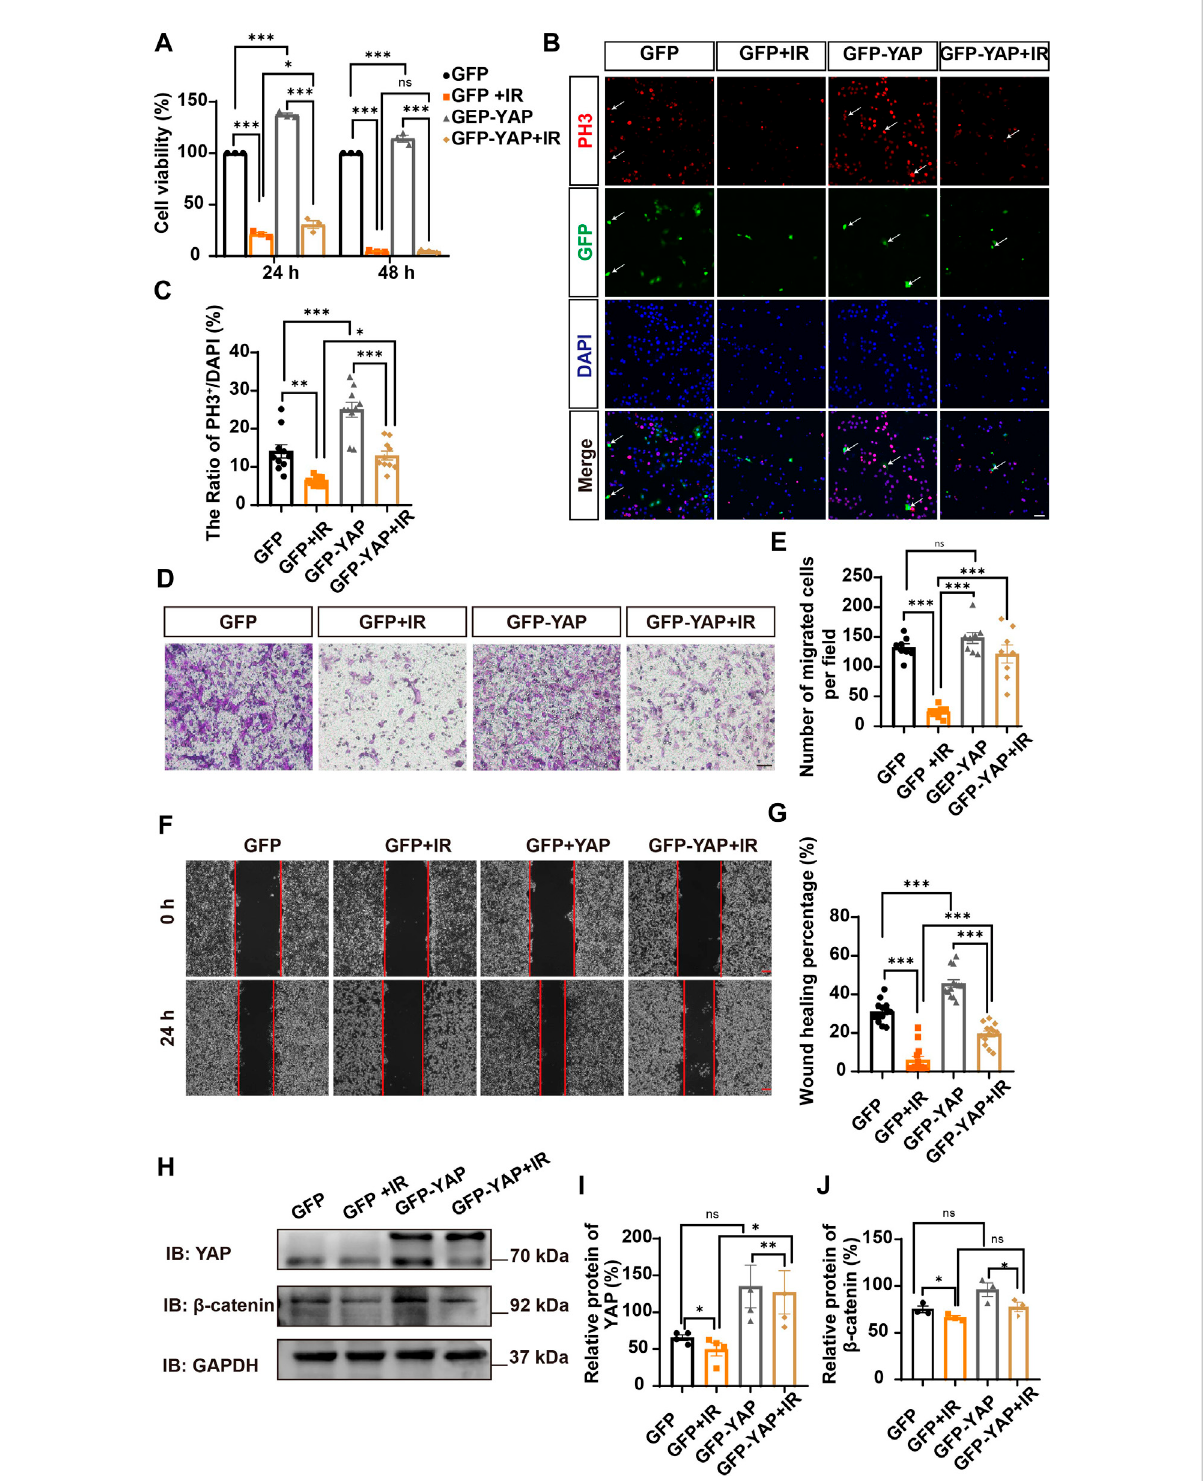
FIGURE 7 Overexpression of YAP partially rescued cell viability and proliferation inhibited by irigenin. (A) The cell viability by CCK-8 in C6 cells transfected with GFPN1 or GFP-YAP for 48 h and then treated with 50 μ M IR and the control ( n = 3, per group). (B) Immunostaining of PH3 (red) in C6 cells was transiently transfected with GFPN1 or GFP-YAP for 48 h and then treated with 40 μ M IR. The white arrow indicated transfected with GFPN1 or GFP- YAP and PH3 + cells. (C) Quantitative analysis of the percentages of PH3 + cells over total C6 cells as shown in (B) (n = 10, per group). (D)